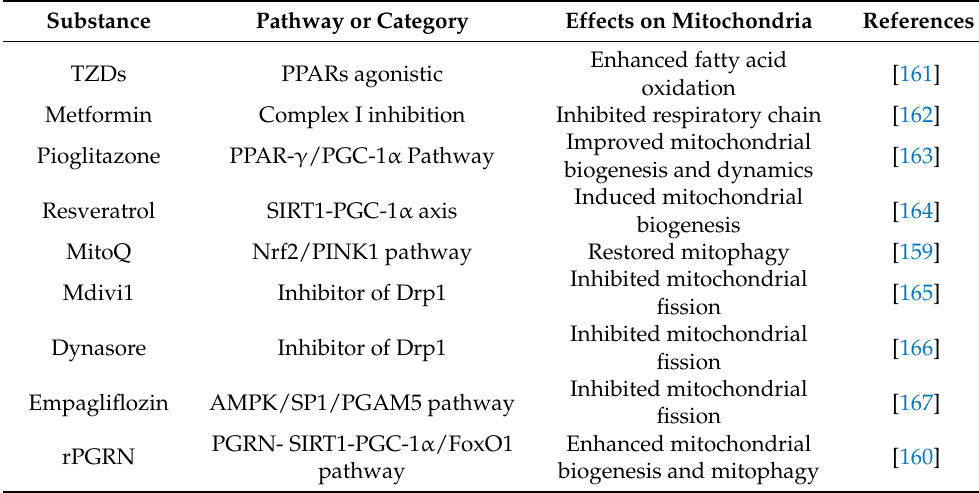
Table 1. The effects of antidiabetic drugs on mitochondrial